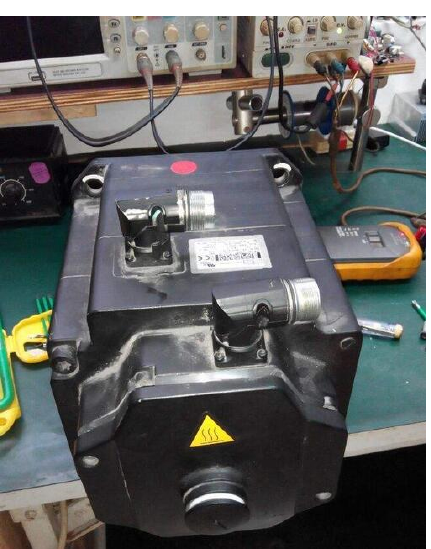
Figure 5. GM7101 motor test